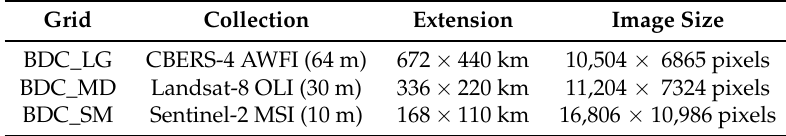
Table 1. Parameters of the hierarchical tiling system used in BDC.